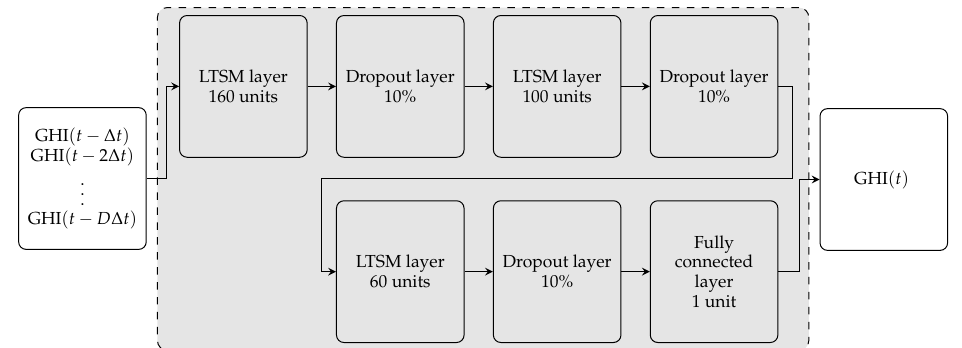
Figure 7. LSTM forecasting model: the network’s topology is defined as a combination of LSTM and dropout layers. The fully connected layer provides the forecast. GHI ( t − ∆ t ) , GHI ( t − 2 ∆ t ) , . . . , GHI ( t − D ∆ t ) is the observation set and ∆ t = 10min is the time